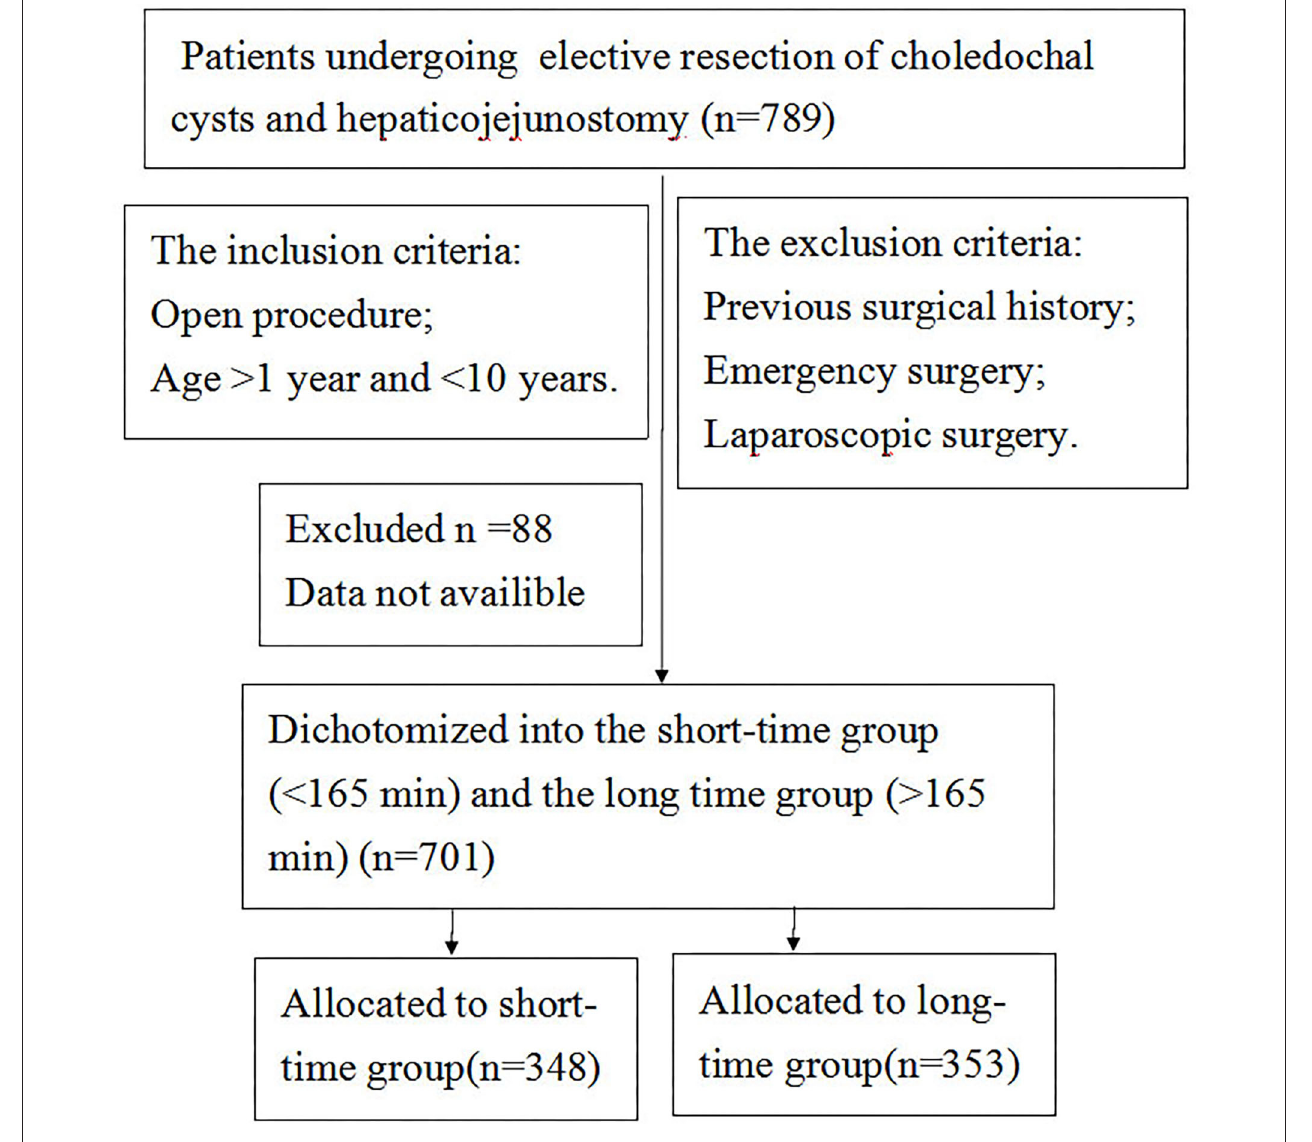
FIGURE 1 | Diagram of the